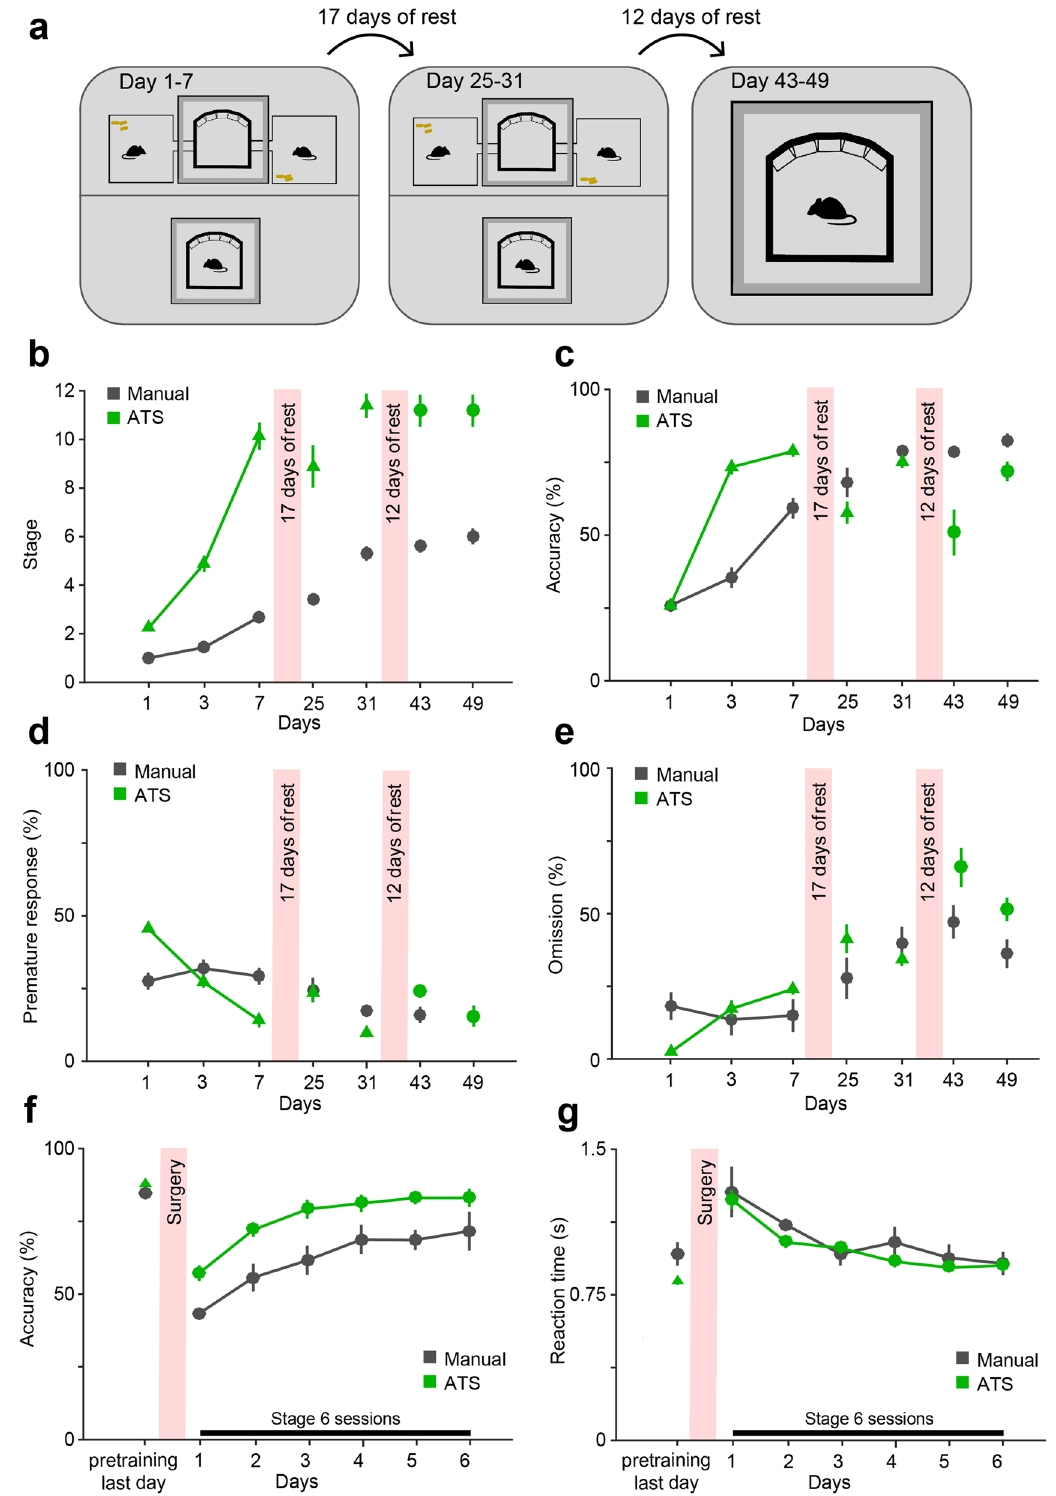
Figure 5. Effect of training breaks on performance. ( a ) Schematics of the experiment. One week of training was followed by a 17-days-long training break, after which mice resumed training from their previous stages in the same setup for another week. Following a second break of 12 days, all mice were transferred to the manual training setup. ( b – e ) Comparison of stage ( b ), accuracy ( c ), premature responses ( d ) and omissions ( e ) between the manual and ATS groups. After both breaks, ATS-trained animals showed a transient lapse in performance compared with manually trained mice, which difference disappeared during one week of training. Manual, N = 16, 10, 10, ATS, N = 16, 8, 6 at training week 1,2 and 3, respectively. ( f – g ) Accuracy ( f ) and reaction time ( g ) after surgical implantation of optic fibers. Mice were pretrained to stage 6 either manually (black) or in the ATS (green) and trained manually after the surgery. The two groups did not differ in their post-surgery recovery of these behavioral measures (no significant time × group interaction, p > 0.05, repeated-measures ANOVA). Manual, N = 5; ATS, N = 14. All values represent mean ±